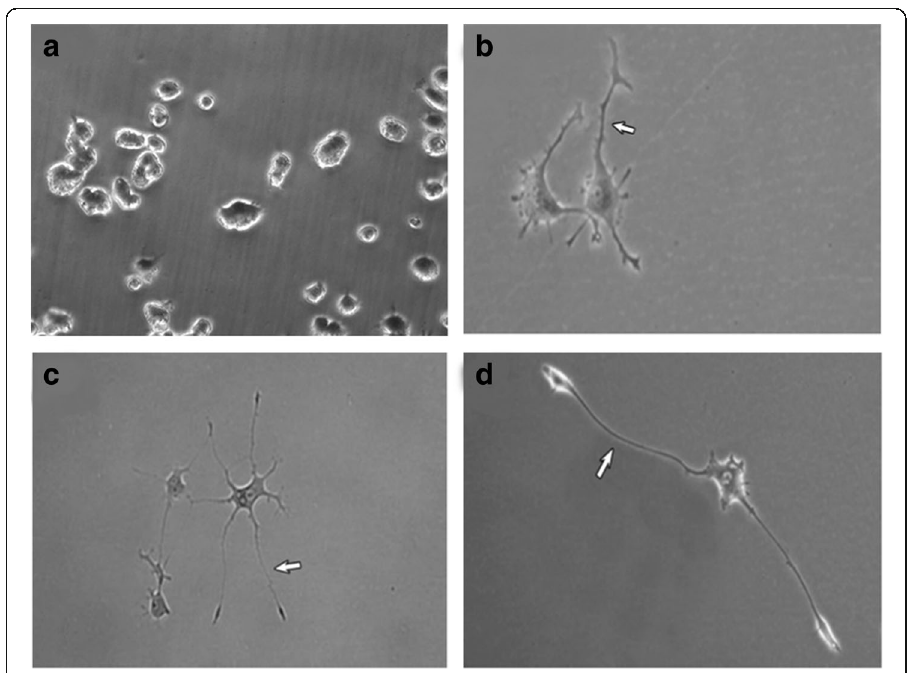
Fig. 1 Images of PC12 cells before day 0 ( a ) and after differentiation for 3 days ( b ), 5 days ( c ) or 7 days ( d ). Arrows indicate the longest neurites